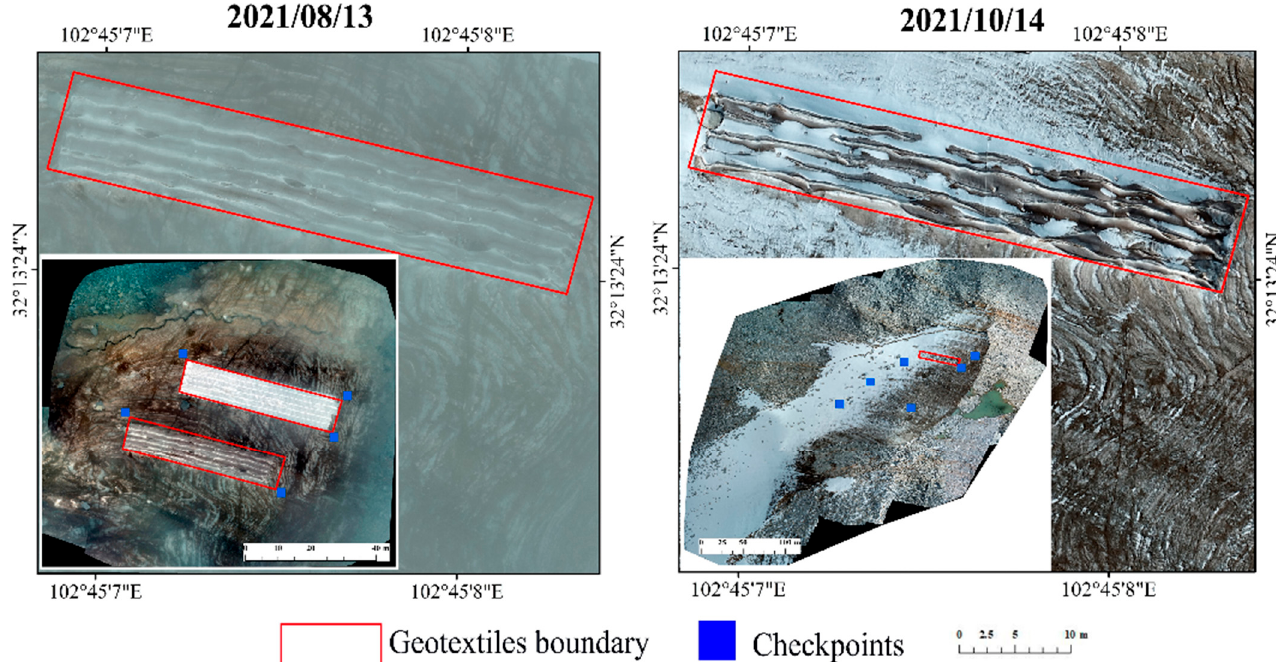
Table 2. Details of the UAV coverage area, flight ‐ related information, and UAVs’ error during the flight over DG17.